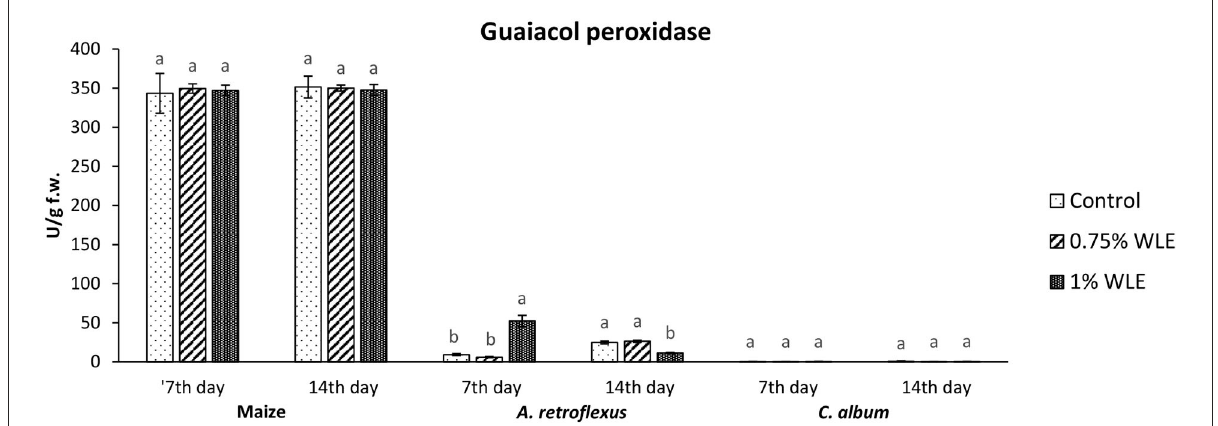
FIGURE4 Activity of antioxidant enzyme guaiacol peroxidase (GPOD) in maize and weeds - Amaranthus retroflexus and Chenopodium album as a response to treatment with 0.75 and 1% walnut leaf extract, on the 7 th and 14 th day after treatment. Data are presented as mean ± SD. Values marked with different letters within a group differ significantly based on Tukey’s HSD test ( p ≤